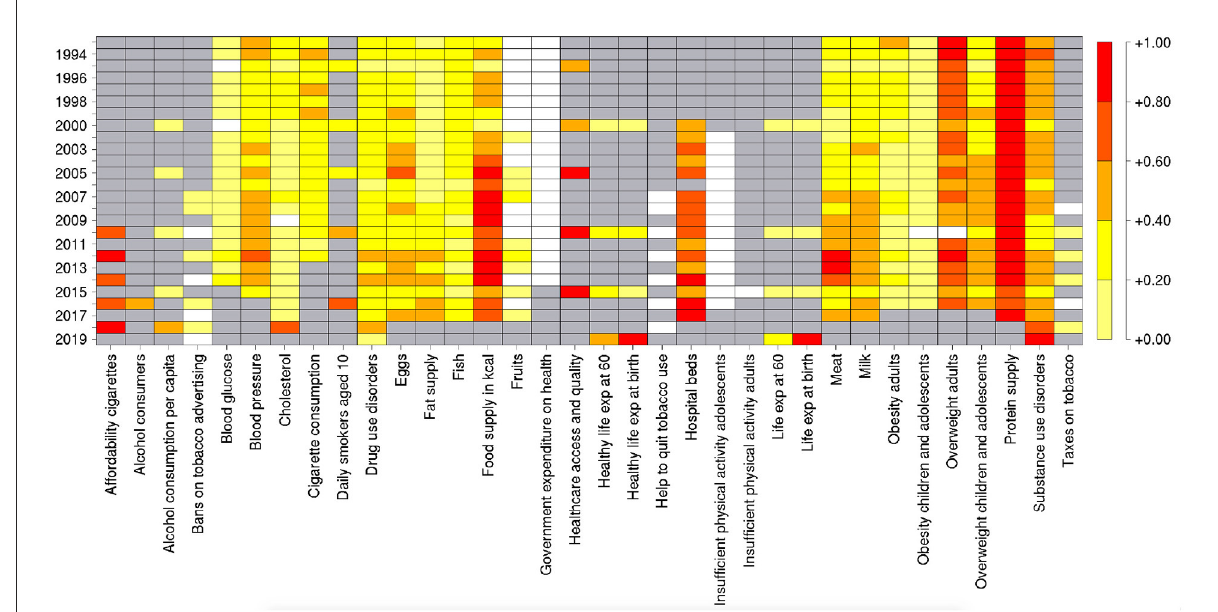
FIGURE5 Average importance of the features used in the RF model over 100 repetitions of the 5-fold cross validation procedure, for 26 different years. The white boxes indicate that the corresponding feature was discarded in the preselection based on the Boruta algorithm. The gray boxes indicate that the corresponding indicators are missing for those years.